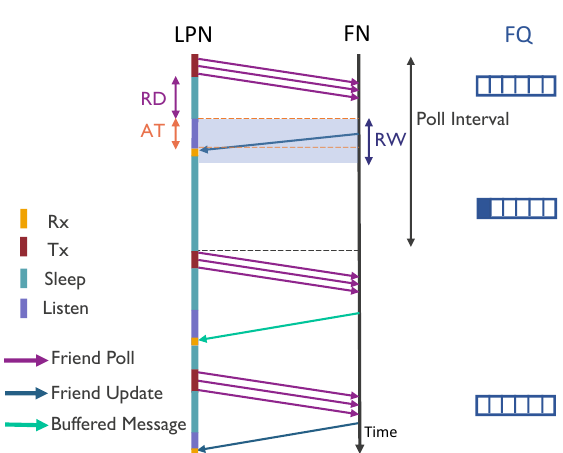
Figure 6. Sequence diagram to receive downlink (DL) data packets using poll-based